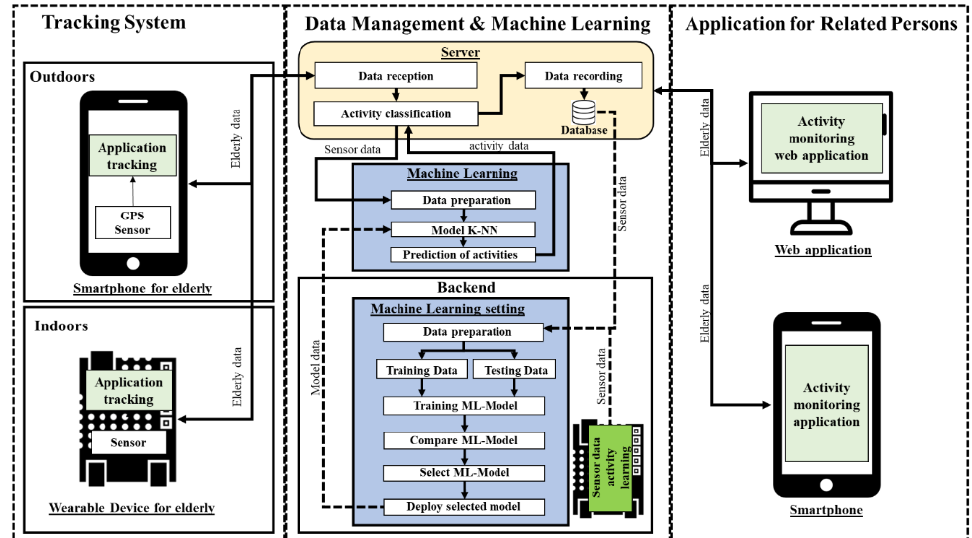
Figure 1. The proposed system